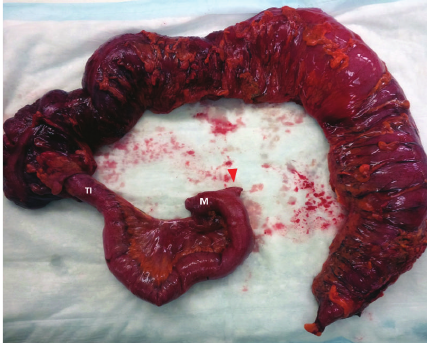
Figure 2: Resected specimen which included the ascending and transverse colon, terminal ileum (TI), and Meckel’s diverticulum (M). The small bowel transection point was chosen just proximal to the Meckel’s diverticulum (red arrow).